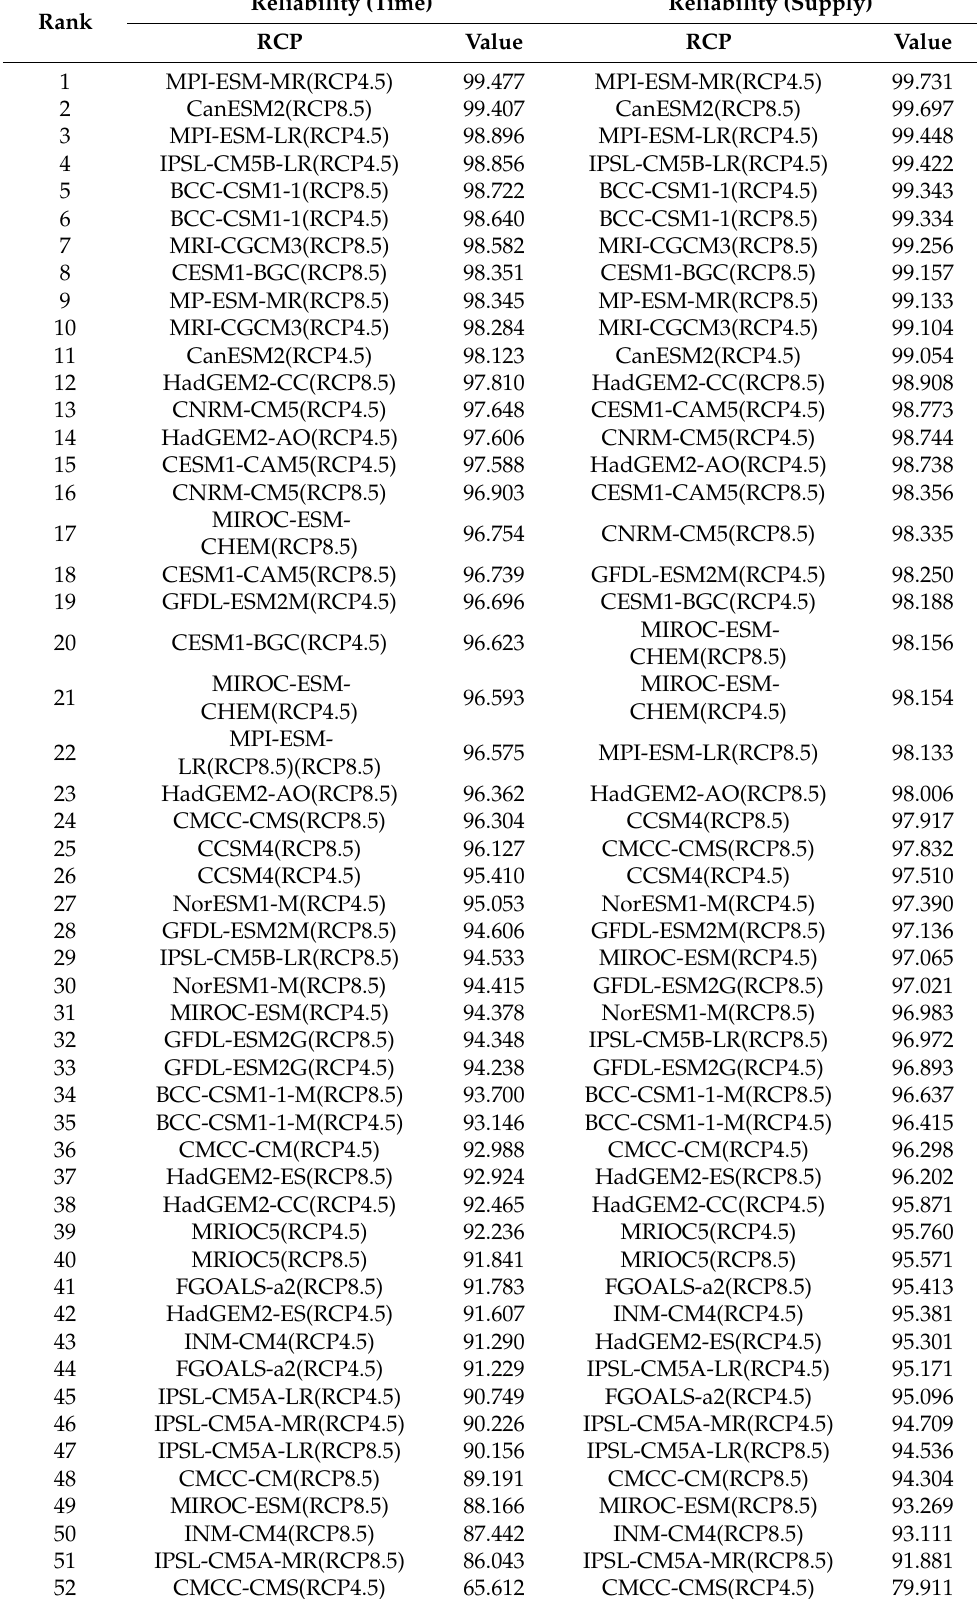
Table 4. Termination criteria for each RCP, reliability time, and reliability